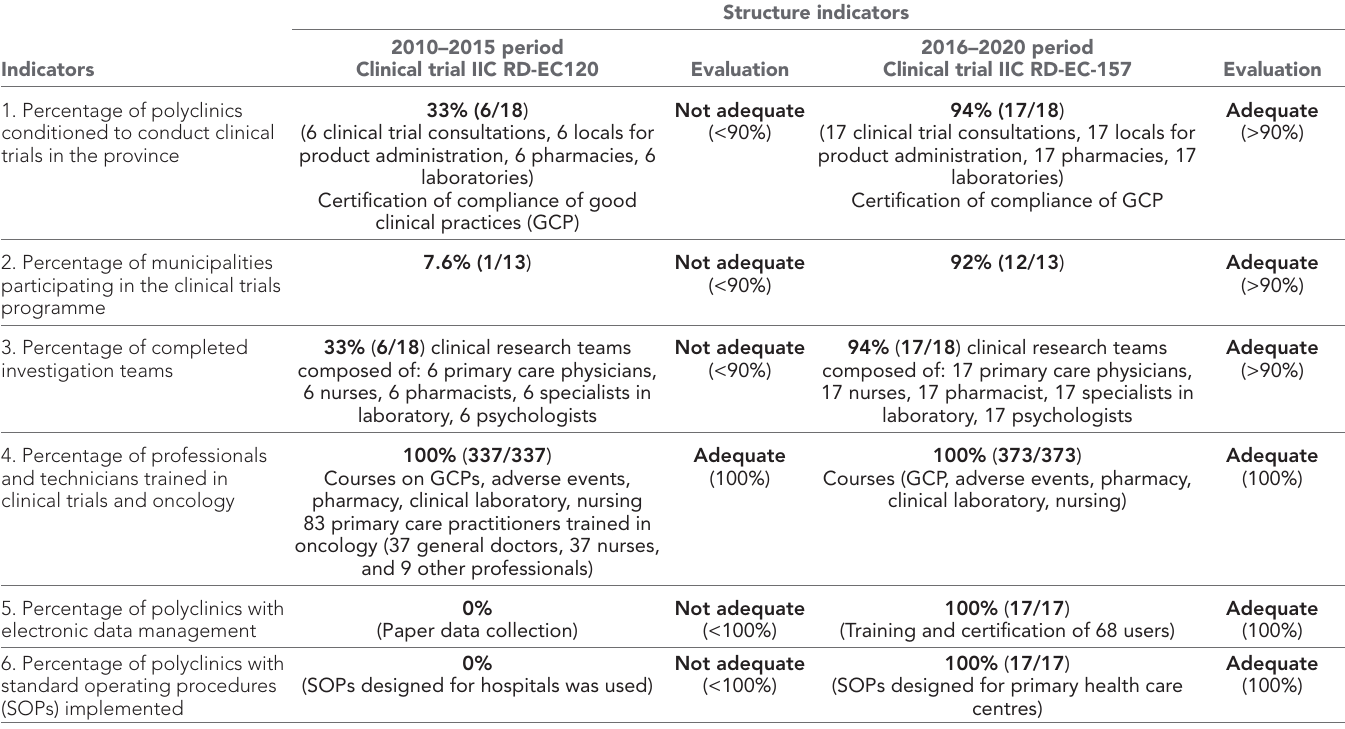
Table 1 Indicators of structure in the conduction of multicentre oncology clinical trials in primary care institutions. Villa Clara